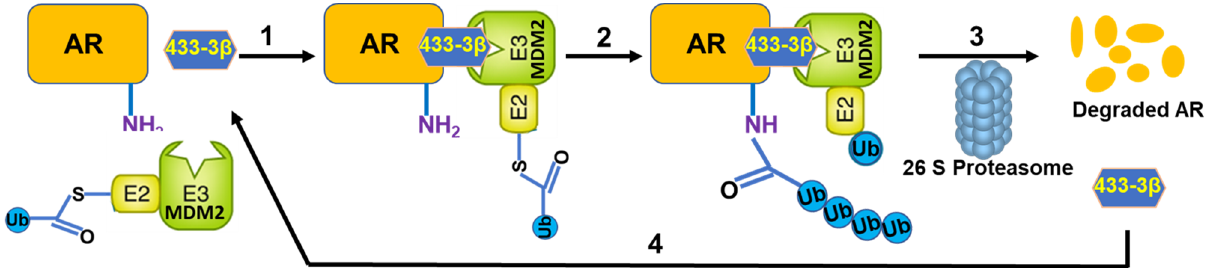
Figure 6. Schematic of the VNPP433-3 β (molecular glue)-induced androgen receptor (f-AR) ubiquitin-proteasome degradation. A ternary complex formed upon binding of VNPP433-3 β (433-3 β , molecular glue), target protein (f-AR) and MDM2 E3 ligase complex (step 1), to promote f-AR protein ubiquitination (Ub) (step 2), followed by f-AR degradation by the proteasome plus release of VNPP433-3 β (step 3). Free VNPP433-3 β can then bind another molecule of AR (step 4) to repeat the degradation cycle.